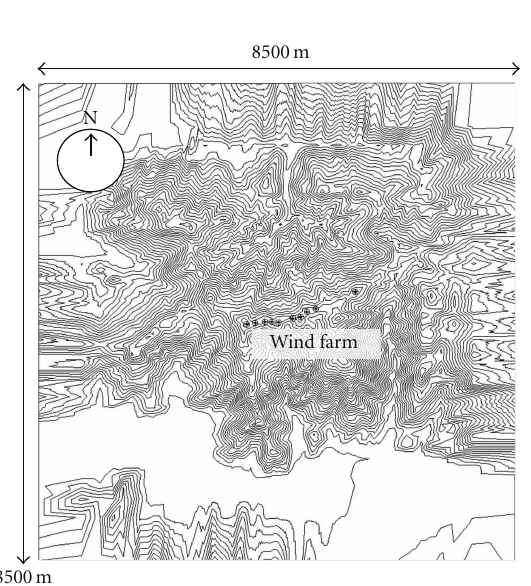
Figure 3: Wind turbine locations and computational